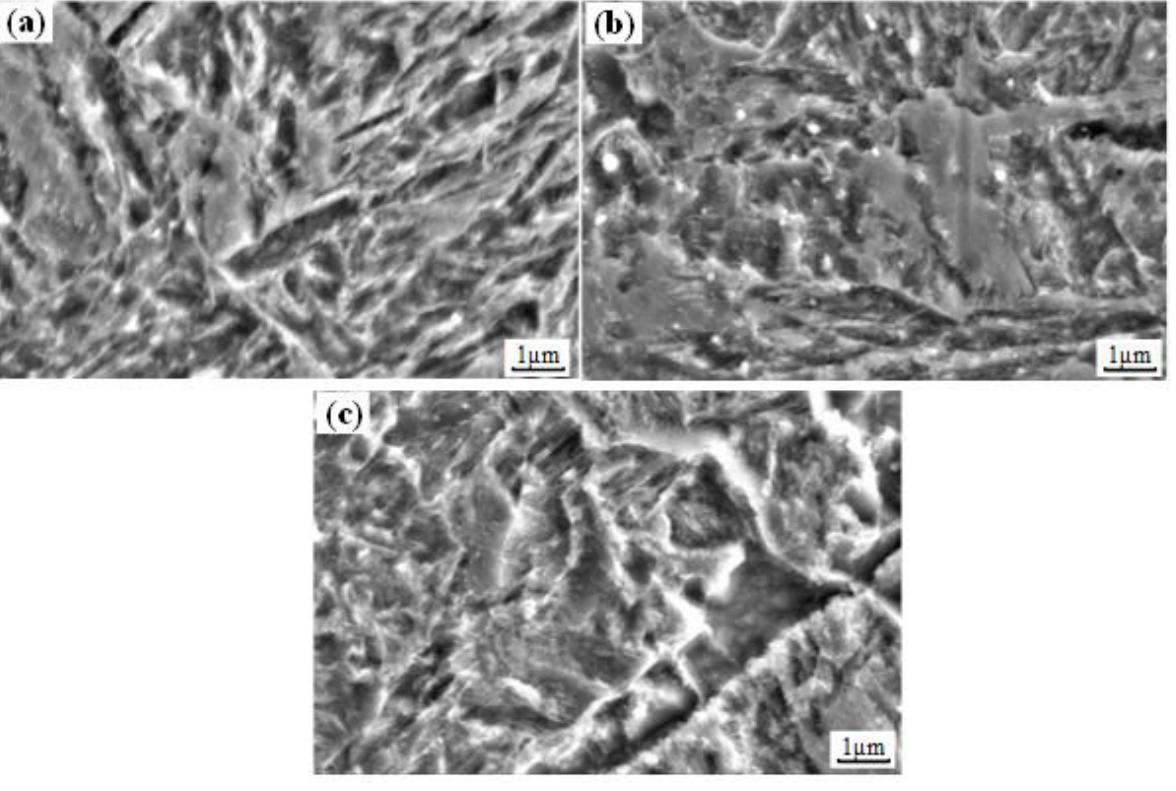
Figure 9. SEM morphologies of ( a ) surface layer, ( b ) subsurface layer, and ( c ) substrate.